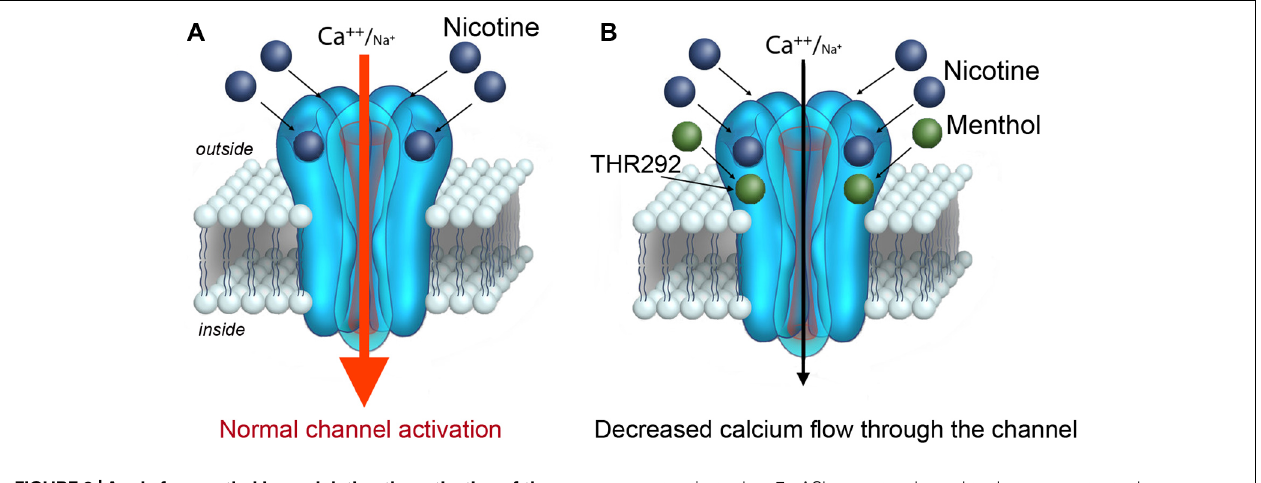
FIGURE 2 |A role for menthol in modulating the activation of the α 7 nACh receptor. (A) Nicotine is a known to bind and activate the α 7 nACh receptor channel at the plasma membrane. Upon binding nicotine, the nACh receptor channel opens conducting calcium (and sodium) into the cell. (B) New findings by Ashoor etal. (2013) reveal that nicotine does